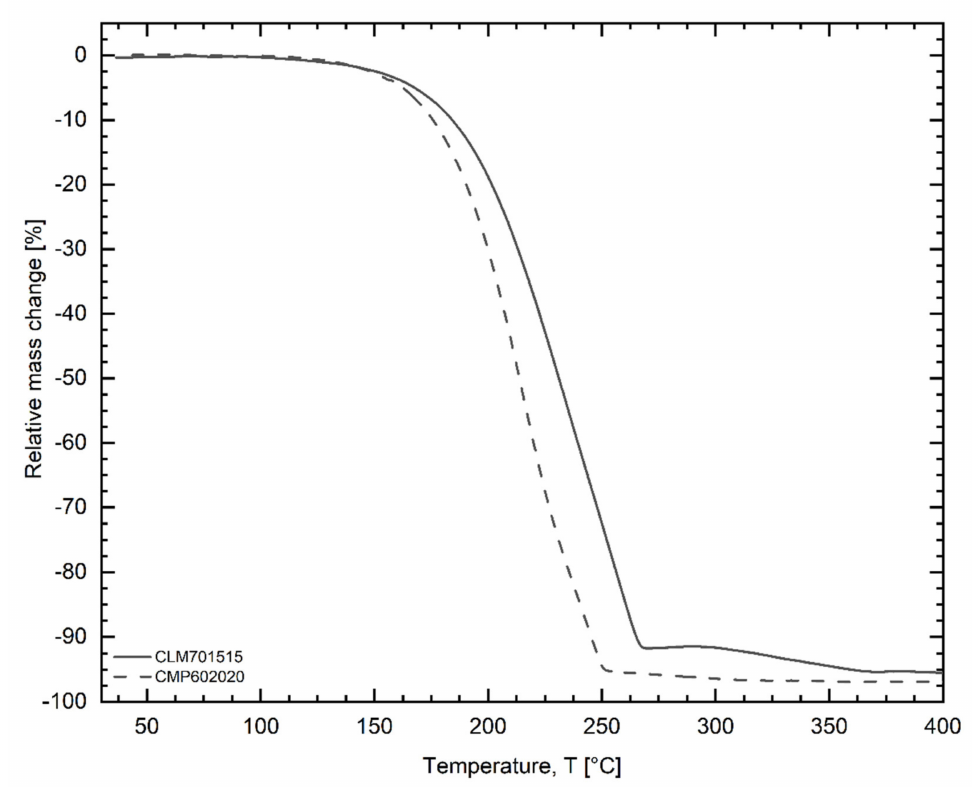
Figure 13. Percentage mass loss with rising